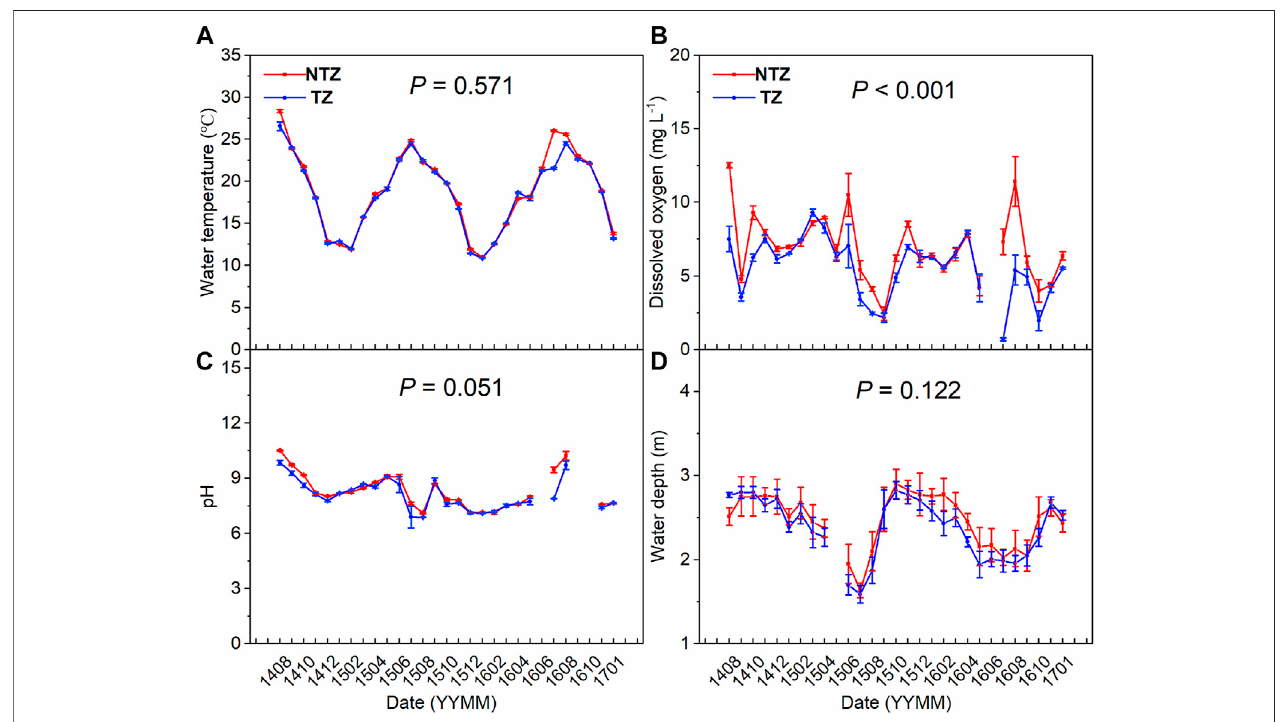
FIGURE2| Waterphysicalparametersoftwoexperimentalzones(NTZ,non- Trapa zone;TZ, Trapa zone;numberofreplicates:4). (A) watertemperature; (B) pHof water column; (C) dissolved oxygen in water column; (D) water depth.